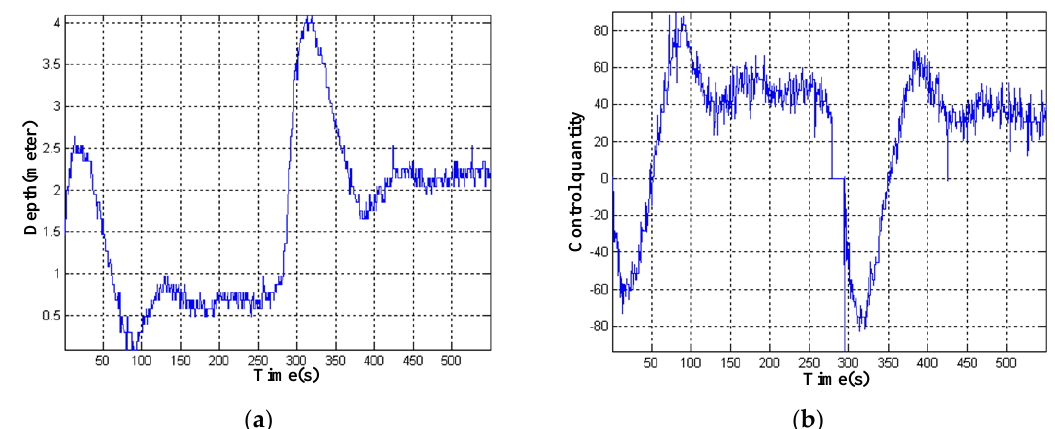
Figure 11. Experiment result of open-loop identification in vertical plane ( a ) depth data; ( b ) control quantity data.